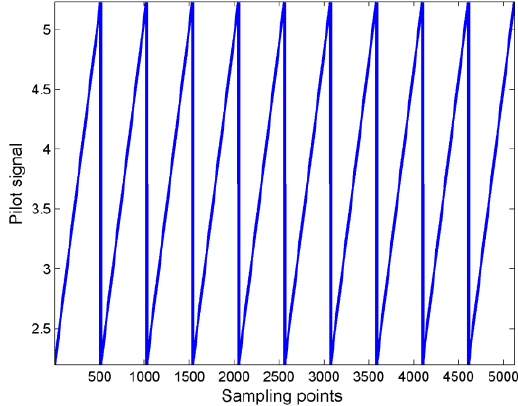
Figure 6. Sawtooth pilot signals.